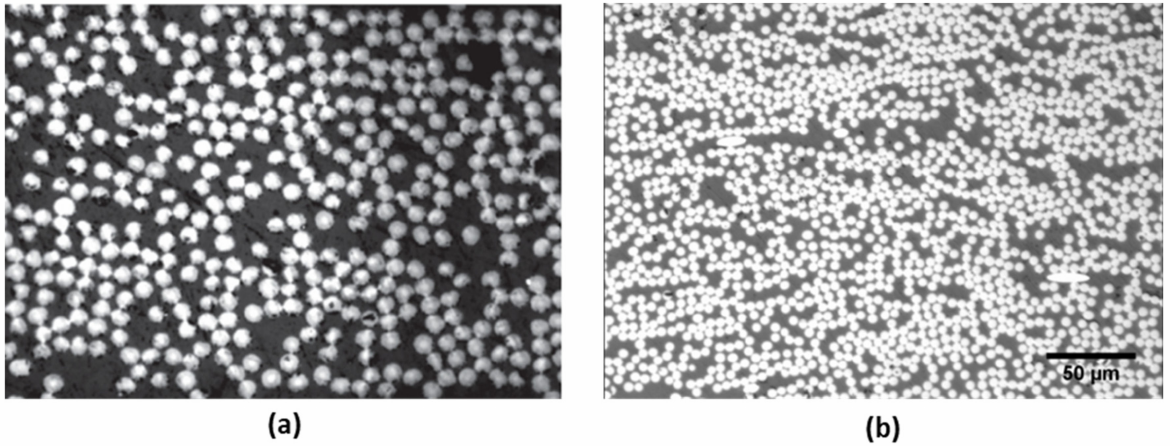
Figure 7. Microstructure of composites produced via ( a ) the HiPerDiF process and ( b ) drum alignment. ( a ) Reprinted with permission from [34]. Copyright 2014 Elsevier. ( b ) Reprinted from [43] under the Creative Commons Attribution 3.0